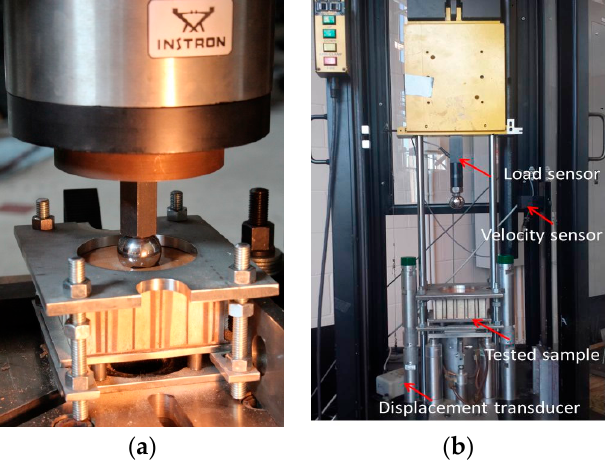
Figure 2. Testing set-up: ( a ) Quasi-Static compression; ( b ) Low-velocity impact